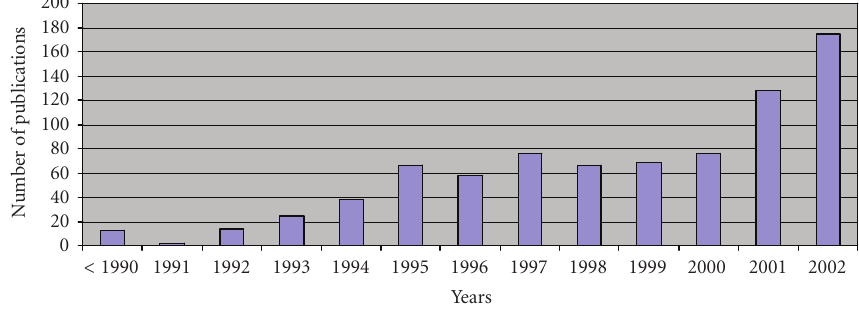
Figure 1: Number of publications per year indexed in MEDLINE using fuzzy